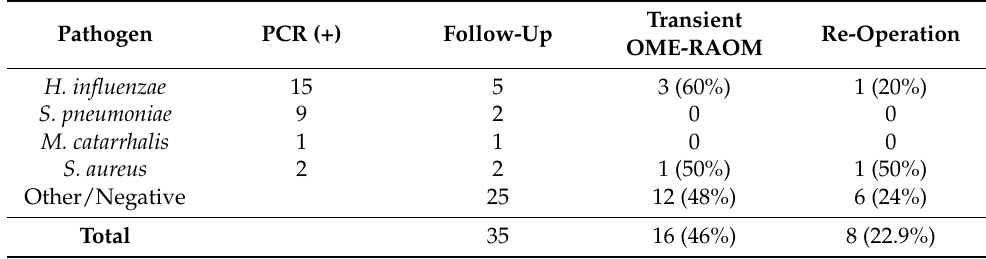
Table 6. Follow-up of RAOM